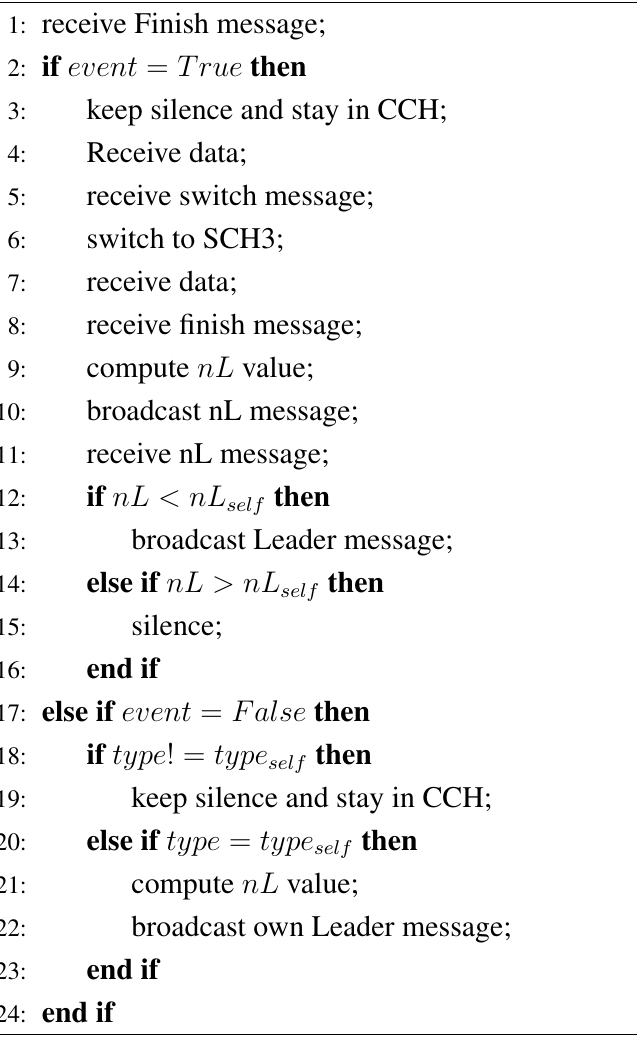
Algorithm 5 Next Leader competition for the